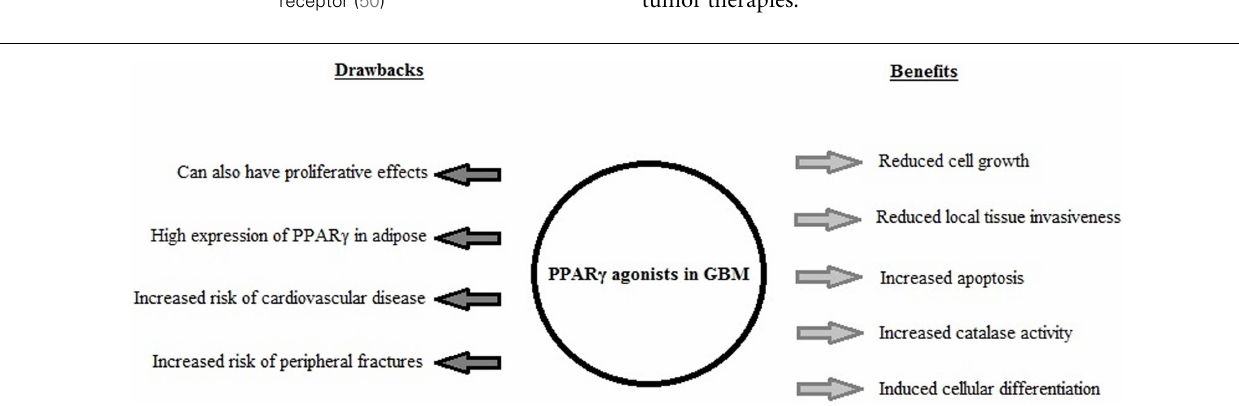
FIGURE 2 |A summary of the biological effects induced by PPAR γ agonist use in GBM in vitro and in vivo , and the drawbacks associated with PPAR γ agonist use in clinical treatment of diabetes mellitus